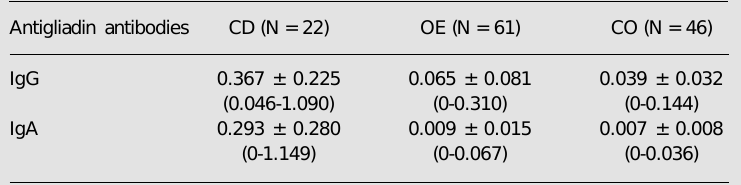
Table 2. Serum antigliadin IgG and IgA in the groups with celiac disease (CD), other enteropathies (OE) and control (CO). Antigliadin antibodies